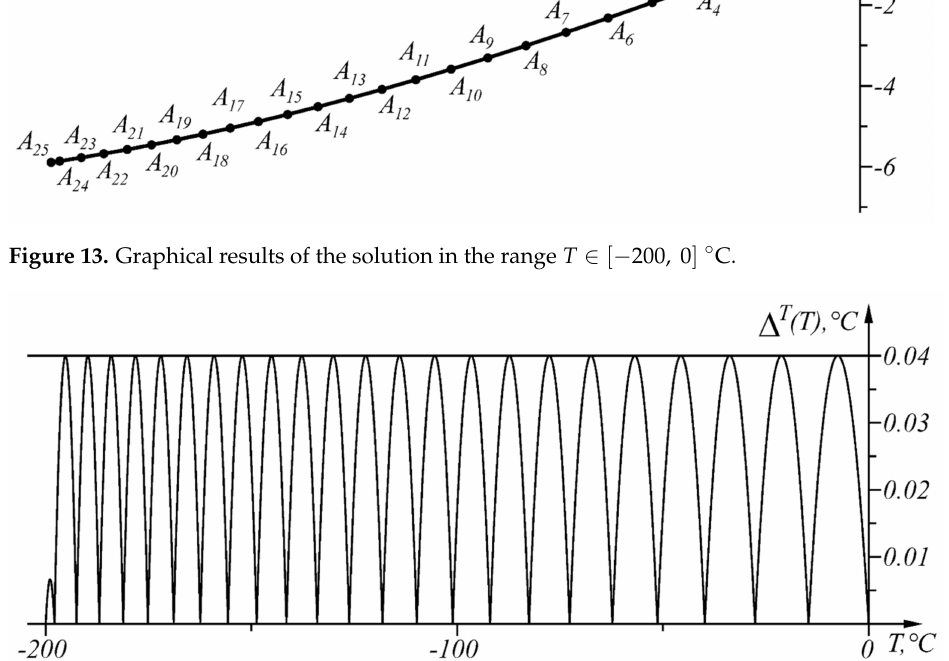
Figure 14. Graph of the function ∆ T ( T ) in the range T ∈ [ − 200, 0 ] ◦